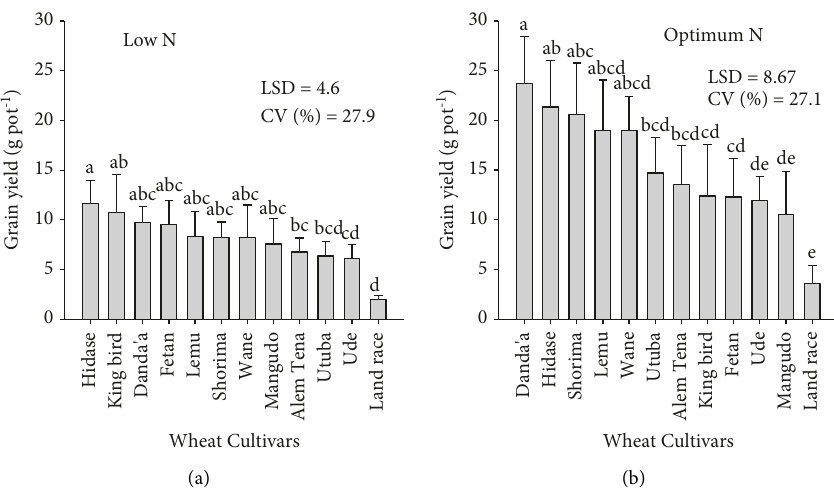
Figure 5: Grain yield of wheat cultivars under low and optimum N supply. Bars followed by similar letters under similar N level are not significantly different from each other at 5% probability level.